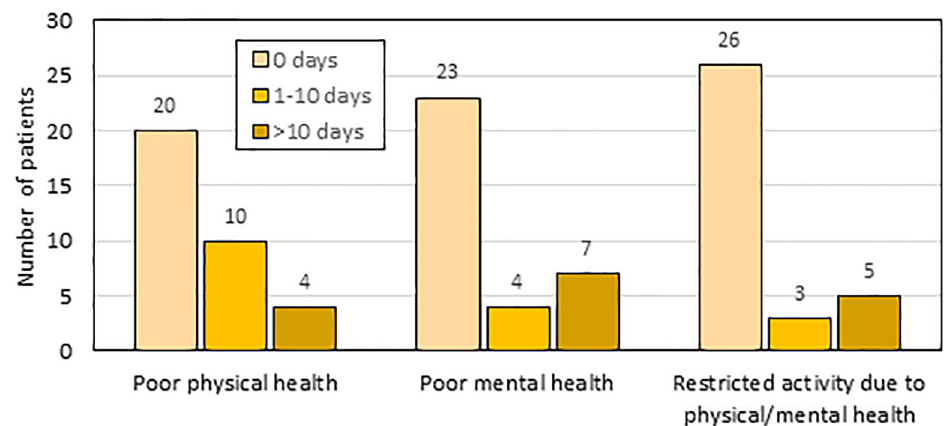
Fig 3. Number of days with physical/mental health issues in previous 30 days. Bar height represents the number of GBS patients with 0 days, 0–10 days, and > 10 days of health issues within the previous 30 days for three different measures of health impairment. Ten patients (29%) reported poor physical health between 1–10 days (in the previous 30 days), while four patients (12%) reported greater than 10 days with poor physical health. Four patients (12%) reported poor mental health between 1–10 days (in the previous 30 days), while seven patients (21%) reported greater than 10 days with poor mental health. Three patients (9%) reported restricted activity due to poor physical or mental health between 1–10 days (in the previous 30 days), while five patients (15%) reported greater than 10 days with restricted activity due to poor physical or mental health.